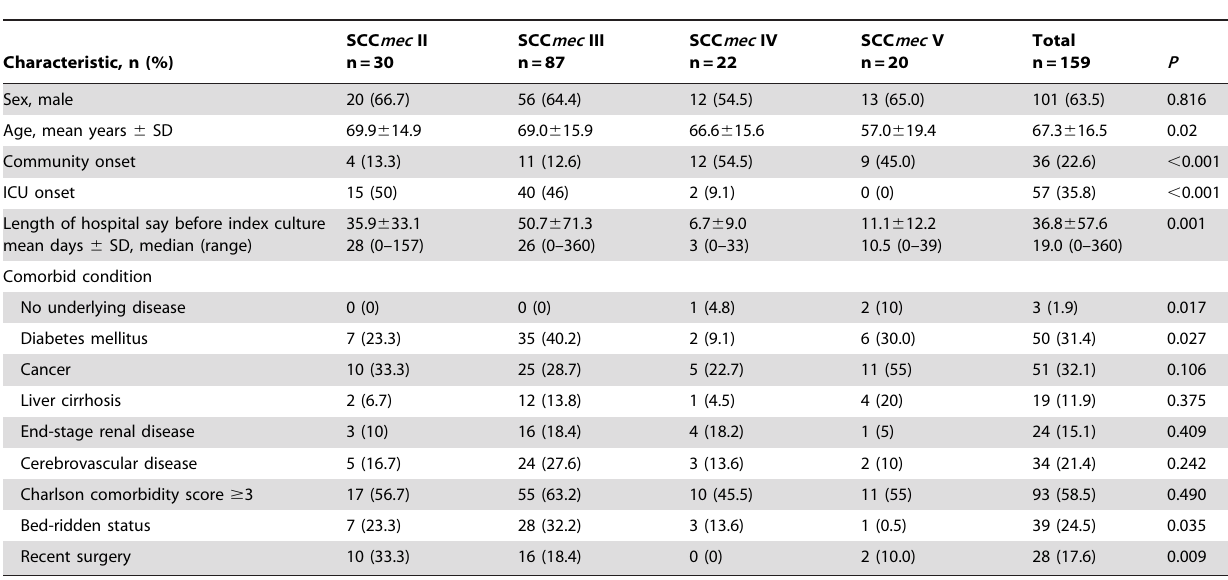
Table 1. Comparison of demographic data and comorbidities of MRSA bacteremia patients with different SCCmec types.